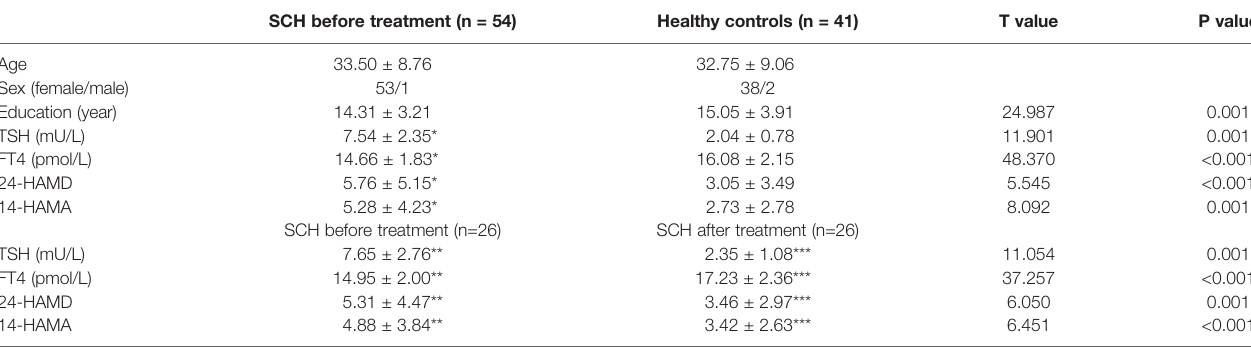
TABLE 1 | Baseline characteristics of SCH patients and healthy controls that completed the study. SCH before treatment (n =